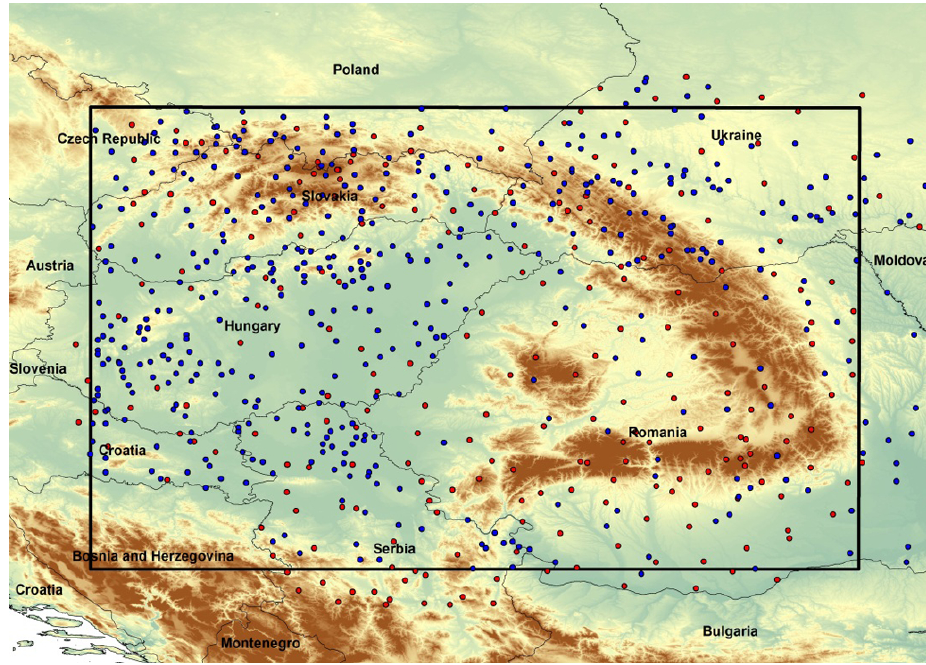
Figure 1. Stations with both RR and T M data (red dots) and station with RR data only (blue dots). The black rectangle encloses the Carpathian Area (44–50 ◦ N, 17–27 ◦ E). Bosnia-Herzegovina must not be considered.